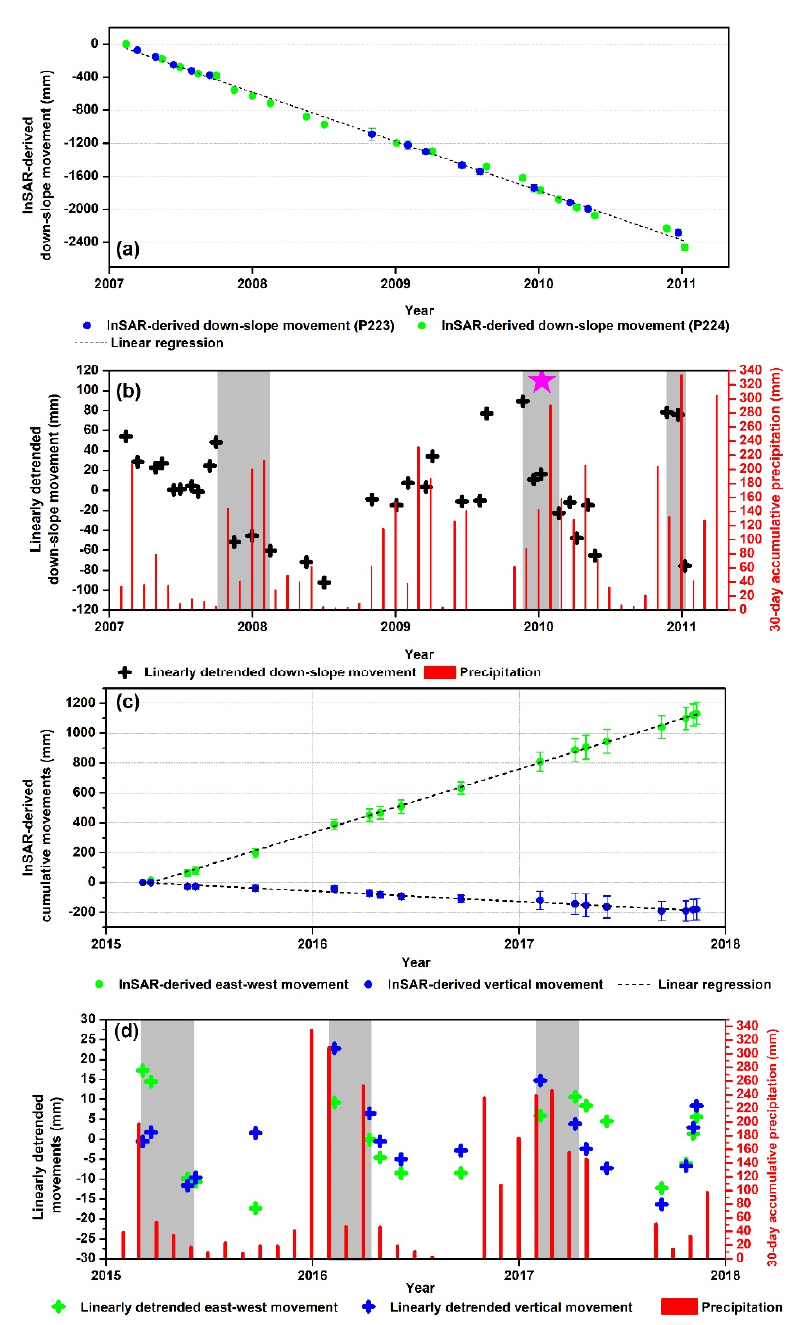
Figure 11. Correlation between the InSAR-derived time-series measurements and 30-day accumulative precipitation. ( a ) Cumulative down-slope movement at FP2 (shown in Figure 5a) by fusing time-series deformation from P223 (blue dots) and P224 (green dots) with the singular value decomposition (SVD) method (2007–2011). ( b ) Comparison between linearly detrended down-slope movement and 30-day accumulative precipitation records. ( c ) Cumulative east–west and vertical movement at FP2 by fusing the ascending and descending interferograms (2015–2017). ( d ) Comparison between linearly detrended two-dimensional movement and 30-day accumulative precipitation records. Here, the point targets within 50 m × 50 m window, centered on the point FP2, were involved to compute the corresponding uncertainty of the time-series deformation. The error bar represents one sigma. The gray box shown in ( b ) and ( d ) indicates the sliding acceleration timespan. The pink pentagram shown in ( b ) indicates the time of the 6.5 Mw earthquake on January 9, 2010.